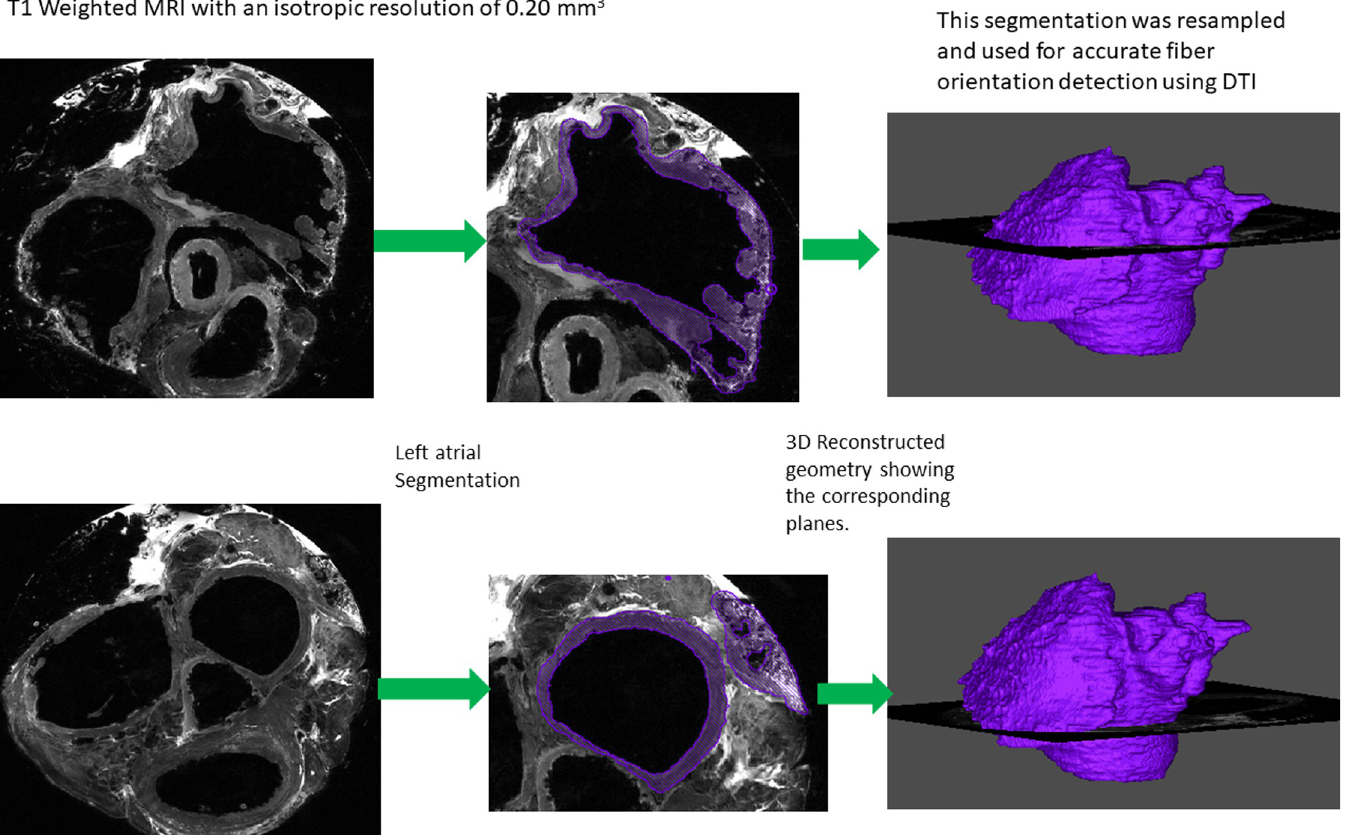
Fig 1. The segmentation of the high-resolution T1-weighted MRI used for the accurate fiber orientation detection using DTI.